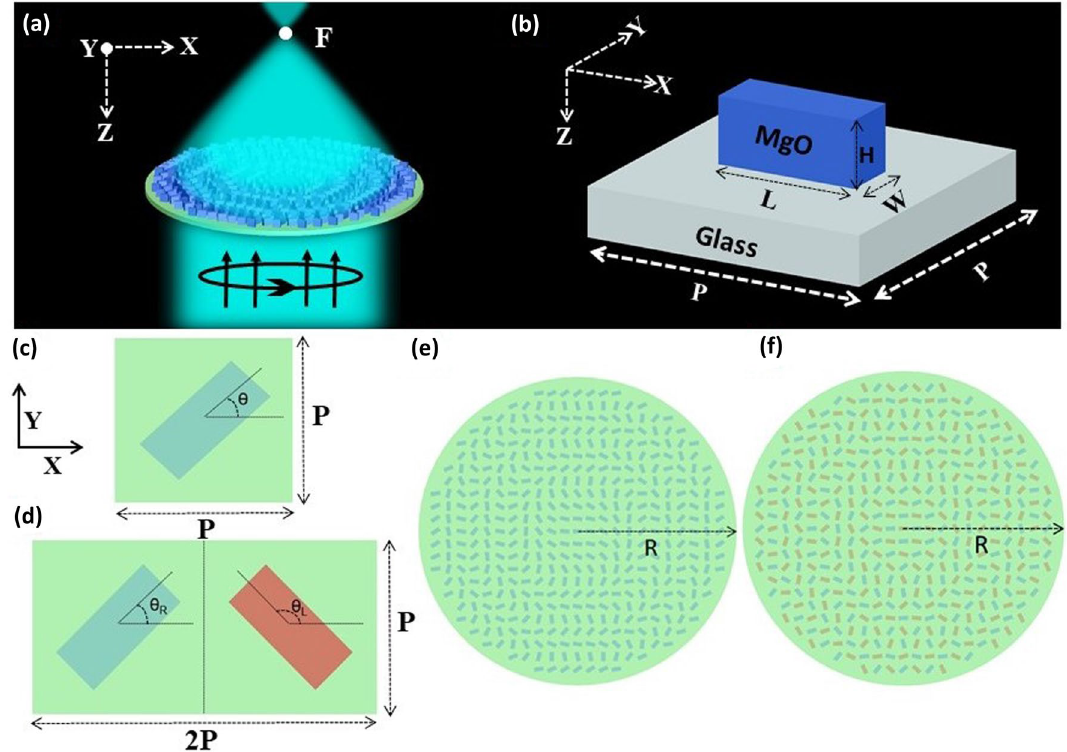
Figure 1. A schematic view of the designed metalens focusing circular polarized incident light at focal point F ( a ), and its MgO building block on glass substrate with height H , length L , width W , and unit cell has the dimensions P × P ( b ). ( c ) The unit cell of a simple metalens, rotated by an angle θ to impart required phase according to geometric P–B phase method. ( d ) Unit cell of a hybrid metalens, where two different colored nanoblocks are rotated by an angle θ R , θ L simultaneously to focus RCP and LCP incident lights. ( e , f ) Top view of the simple, and hybrid metalens of radius